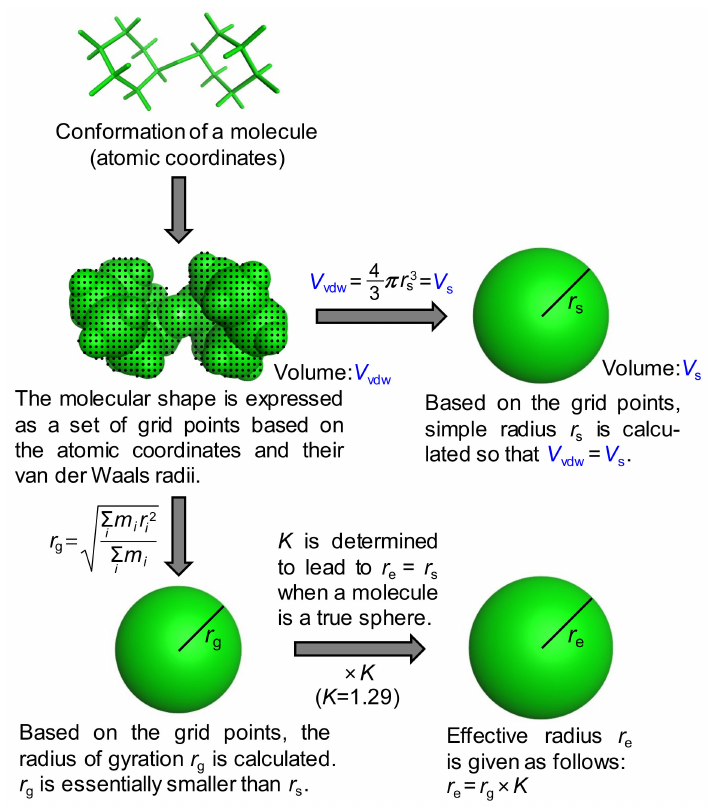
Figure 2. Derivation of the simple radius r s and the effective radius r e , of a molecule. In the case of the radius of gyration r g , the mass is treated as evenly distributed in the molecule.